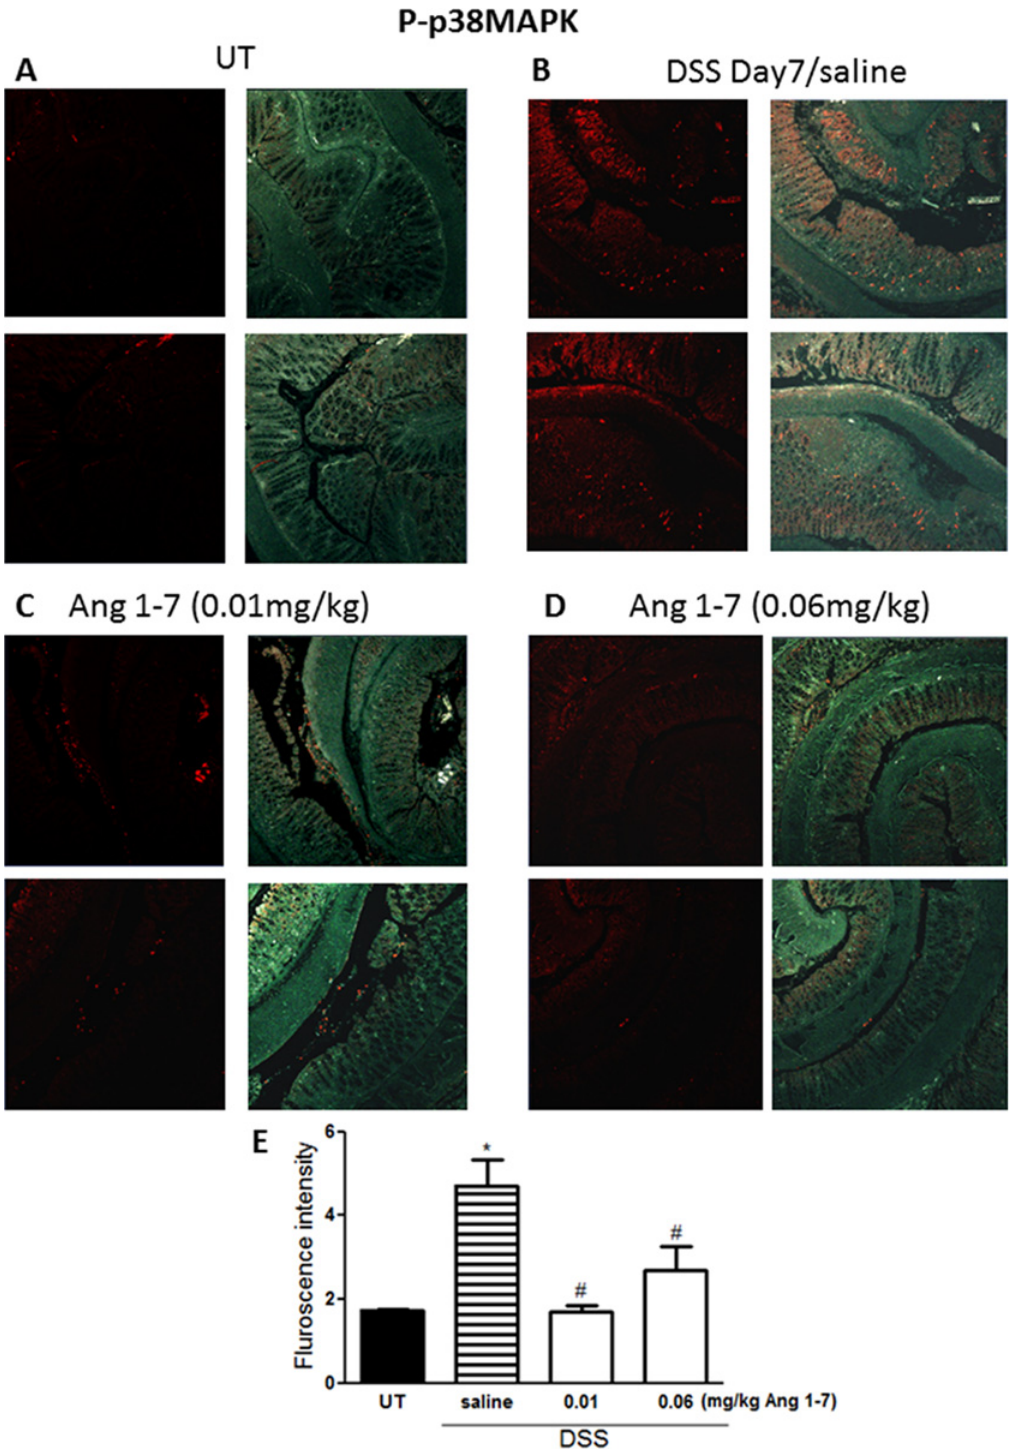
Fig 9. Immunofluorescent detection of phosphorylated p38 MAPK in colon sections. Panel E represents quantitative assessment of fluorescence intensity (arbitrary units). Histobars represent means ± SEM for 3 mice in each group. Asterisk denotes significant difference from UT mice, with p < 0.05, and # denotes significant difference from DSS/ i.p saline (vehicle) treated mice, with p < 0.05.